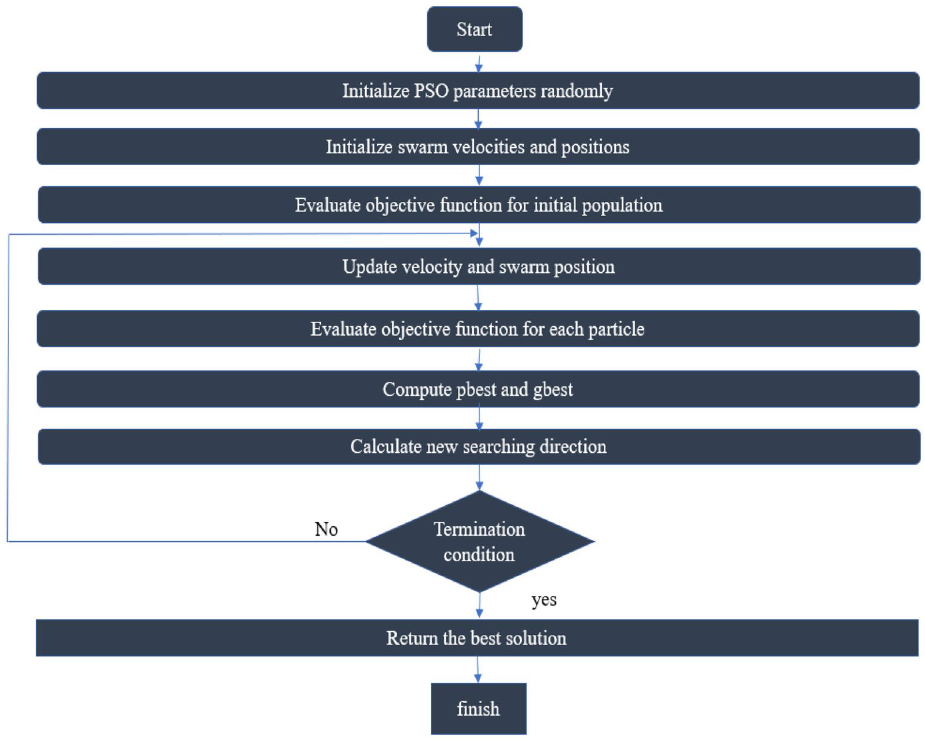
Figure 1. The PSO optimization algorithm flowchart. Source: Authors’ construction using